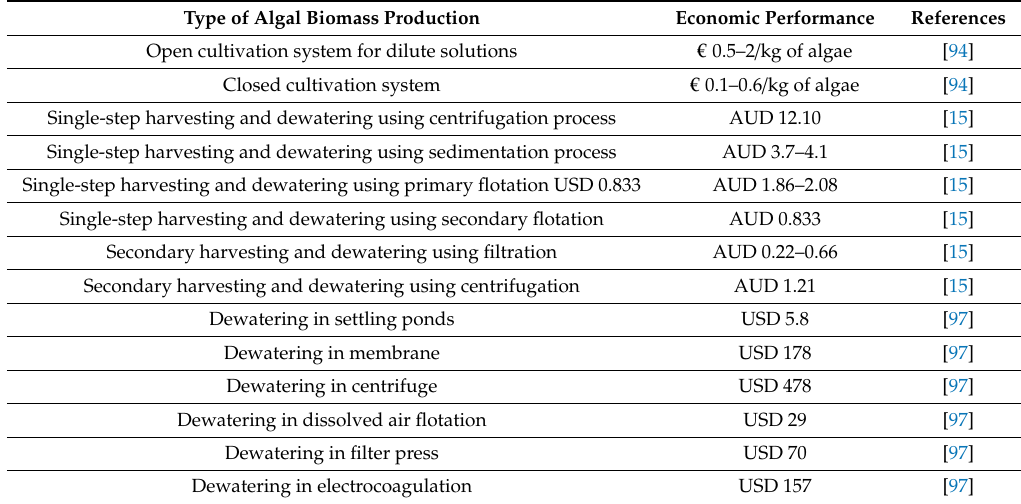
Table 8. Economic performances of various algal biomass production